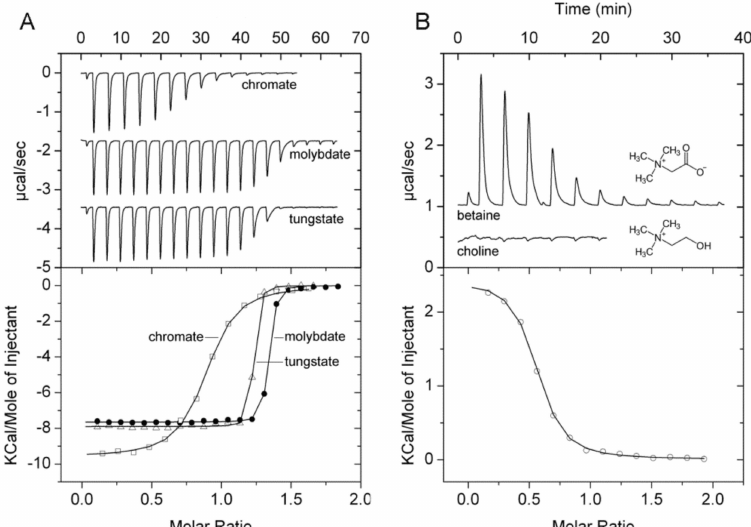
Figure 9. Microcalorimetric binding studies of metal oxanions and quaternary amines to di ff erent solute binding proteins of P. aeruginosa . ( A ) Titration of 40 µ M PA1863 with 1 mM solutions of Na 2 MoO 4 , K 2 Cr 2 O 7 , or Na 2 WO 4 (6.4 µ L aliquots). ( B ) Titration of 169 µ M PA3889 with 5 mM glycine-betaine (6.4 µ L aliquots) and 40 µ M PA3889 with 1 mM choline (6.4 µ L aliquots). Upper panel: Raw titration data. Lower panel: Dilution heat corrected and concentration normalized integrated raw data. The line is the best fit using the ‘One Binding Site’ model of the MicroCal version of